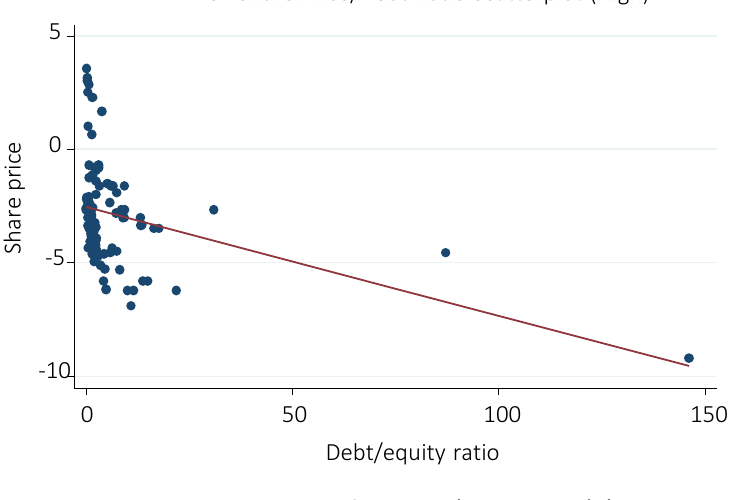
Figure 5. Share price-debt ratio